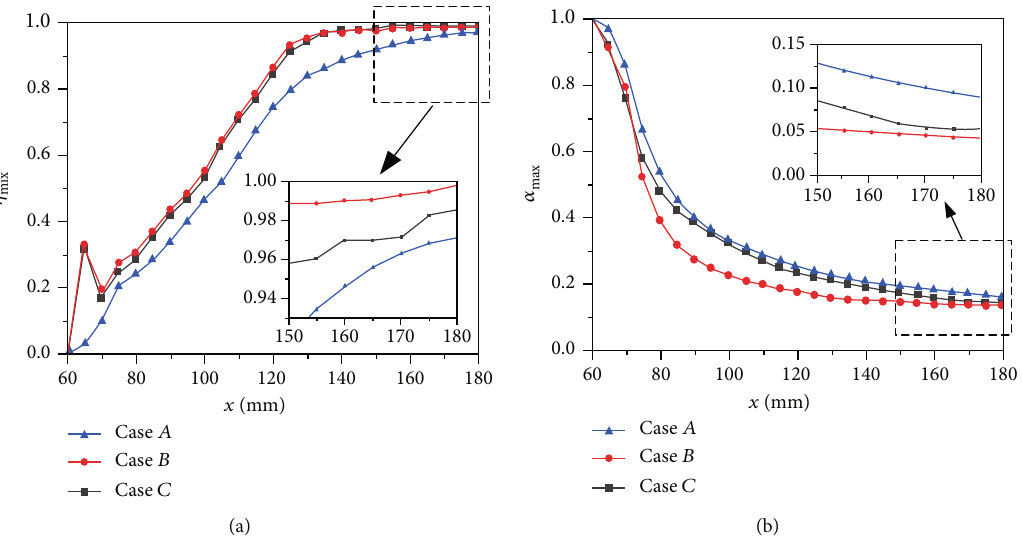
Figure 9: Mixing e ffi ciency of ethylene (a) and the corresponding maximum concentration decay curve (b) in case A without actuation and case B -case C with streamwise